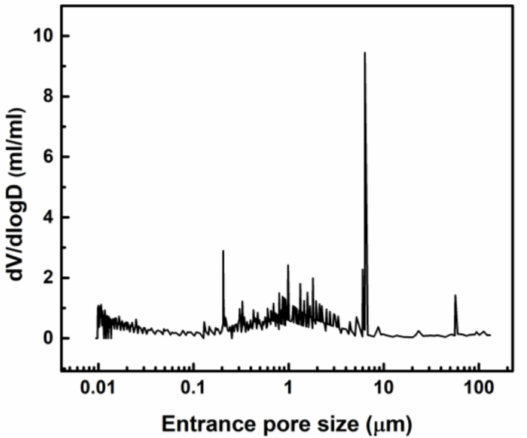
Figure 4. Entrance pore size distribution of lyophilized PVP hydrogel obtained by MIP.